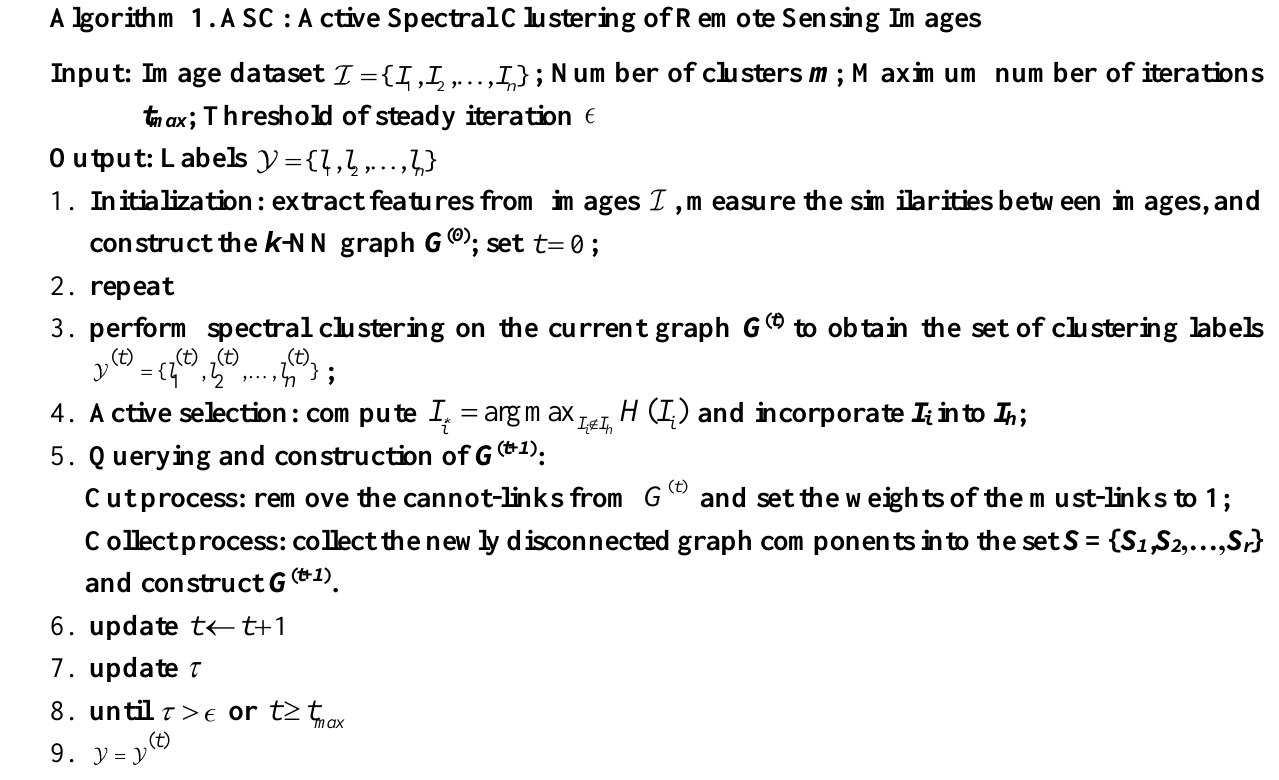
Algorithm 1. ASC: Active Spectral Clustering of Remote Sensing